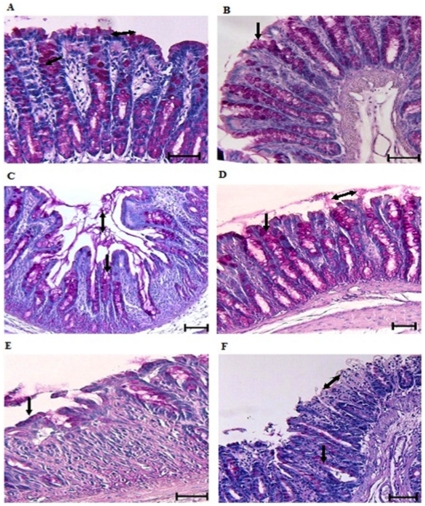
The effect of TNF-α neutralizing antibody on the adherent mucus layer and goblet cell mucin in DSS-induced colitis.Rat colonic tissues sections were stained with Periodic acid Schiff reagent to visualize adherent and goblet cell mucin content. A: DSS treatment alone on day 2 showing mucin filled goblet cells (magenta color) and secreted mucin in the lumen (double head arrow) with a modest inflammatory infiltrate. B: TNF-α neutralizing antibody plus DSS treatment on day 2, showing mucus secretion from crypt goblet cells. C: DSS treatment only rat on day 5 showing disrupted crypts, intense inflammatory cellular infiltrate and intense mucus secretion from crypt goblet cells (single head arrow) with loss of the adherent mucus layer (double head arrow). D: TNF-α neutralizing antibody plus DSS treatment on day 5 showing well organized crypts filled with mucin (single head arrow) and an adherent mucus layer (double head arrow) on the surface epithelium. E: DSS treatment on day 9 showing an ulcerated region with a ruptured mucosa with complete loss of crypts. The residual goblet cells adjacent to the ulcer show remnants of mucin. F: TNF-α neutralizing antibody plus DSS treatment on day 9 demonstrating only to the surface mucosa (double head arrow) and the deep crypts show evidence of mucin in goblet cells beneath the lesions (single head arrow). Scale bar represents 25 µm.